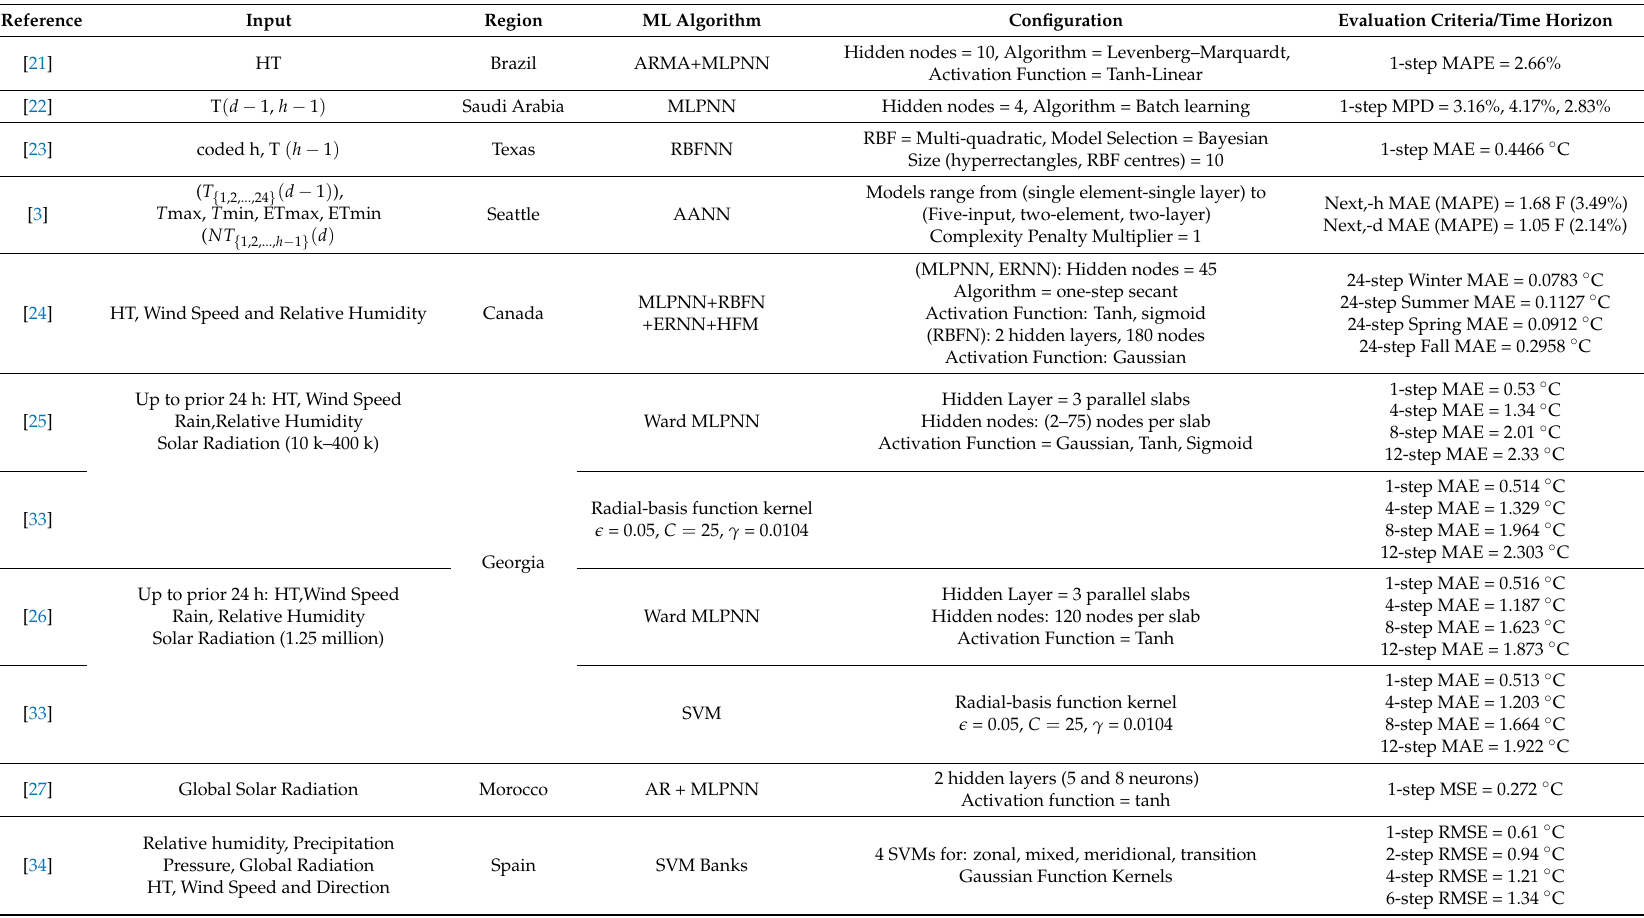
Table 2. Representative papers related to Hourly Temperature